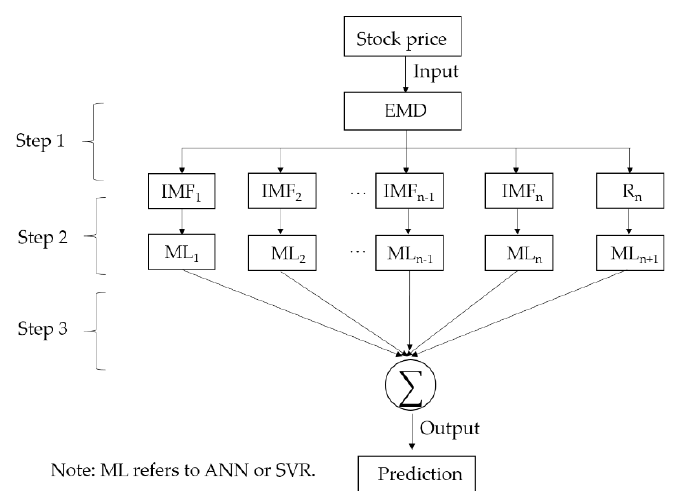
Figure 4. Overall process of the EMD-based model.